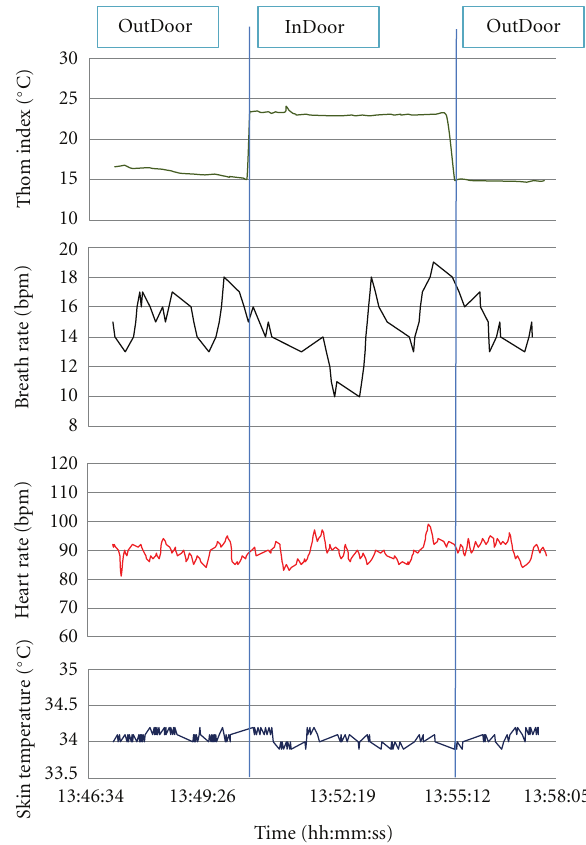
Figure 7: Health care monitoring